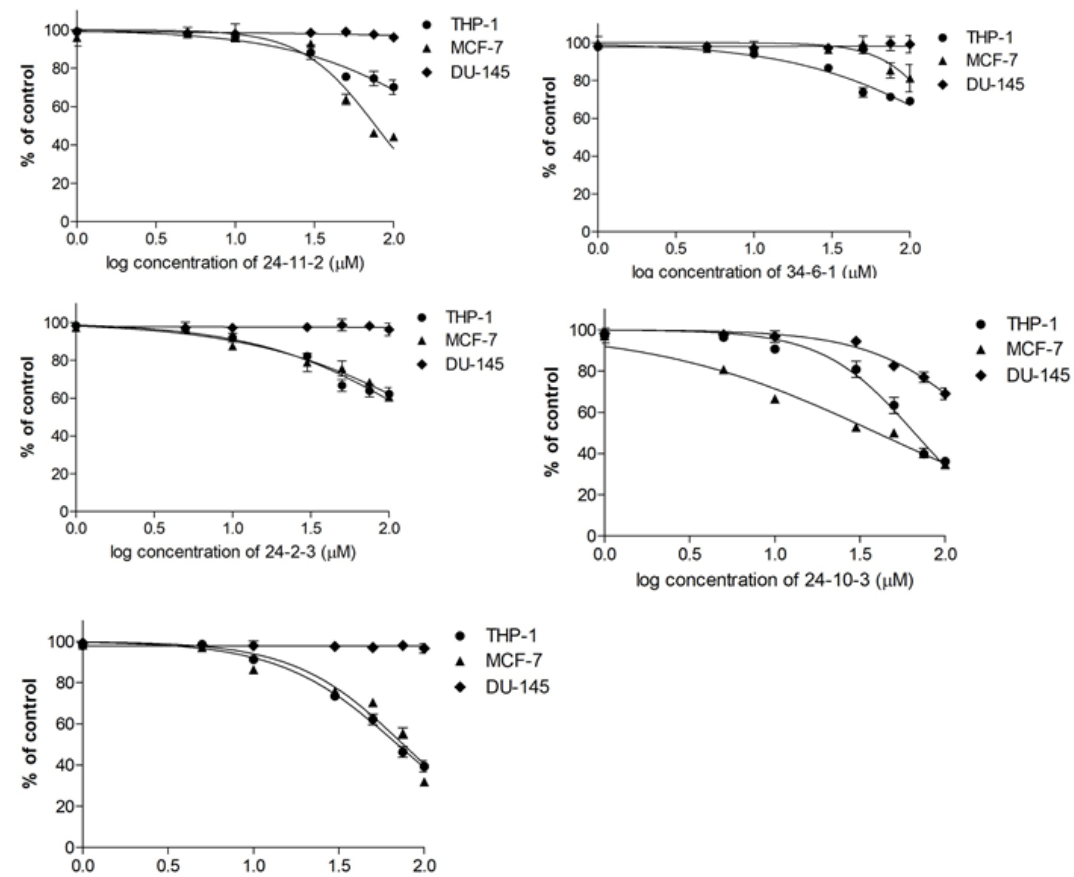
Figure 2. Effect of tested compounds on cell proliferation in THP-1, MCF-7, and DU-145 cell lines after 48 h of incubation. Proliferation was determined using WST-1 assay. The results are shown as the mean ± SD of three independent experiments, each performed in triplicate. Specific values, including statistical analysis, are given in the Supplementary Materials.